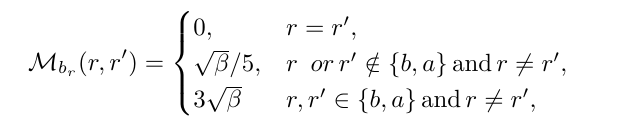
Figure 1. Graph M representing gr b ms ( S , M b